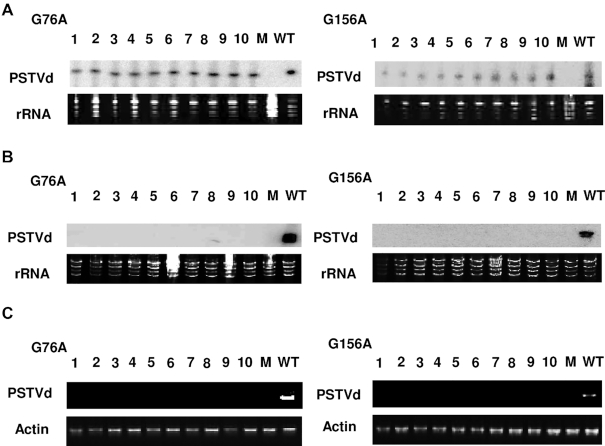
PSTVd G76A and G156A mutants fail to exit rub-inoculated leaves. RNA was collected from (A) rub-inoculated leaves, (B) systemically infected leaves, or (C) petioles of inoculated leaves of 10 plants infected with G76A or G156A. Wild type PSTVd (WT) was a positive control, and mock inoculation (M) was a negative control. (A) RNA blots show a 100% infection rate (10/10 plants) for both mutants in rub-inoculated leaves. (B) Absence of signal on RNA blots indicates both mutants are unable to traffic to upper leaves following rub inoculation. (C) Absence of detectable RT-PCR products indicates that G76A and G156A fail to exit inoculated leaves. Loading controls were ribosomal RNA (A and B) and RT-PCR of actin mRNA (C), detected by ethidium bromide staining. Images are representative of eight (A and B) and three (C) independent experiments.